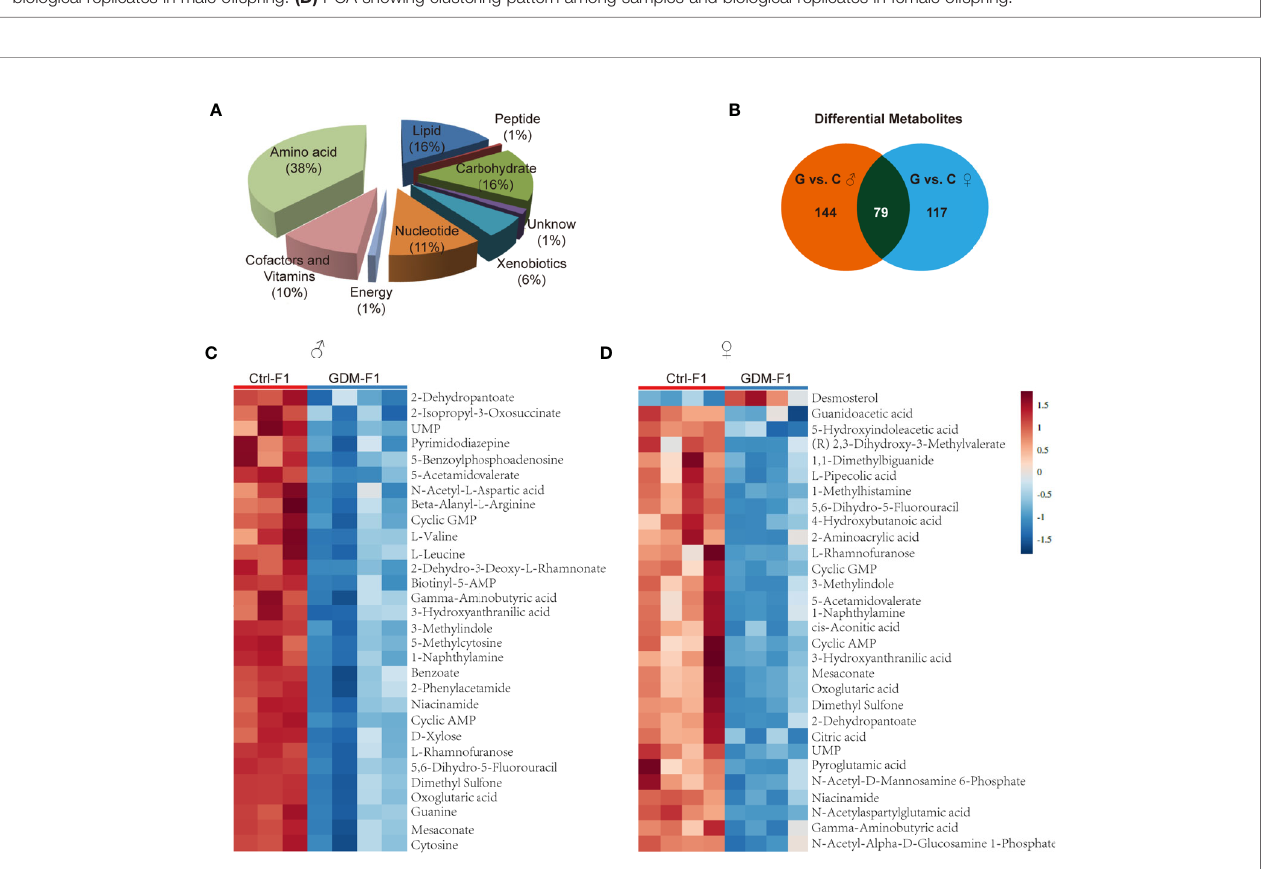
FIGURE 3 | Overview of the metabolome pro fi les in GDM fetal pancreas. (A) Classi fi cation of the detected metabolites into major functional classes. (B) Venn diagrams of different metabolites in GDM-F1 and Ctrl-F1 group and overlapped metabolites between male and female. (C) Heatmap presentation of the top 30 differential metabolites in male pancreas. (D) Heatmap presentation of the top 30 differential metabolites in female